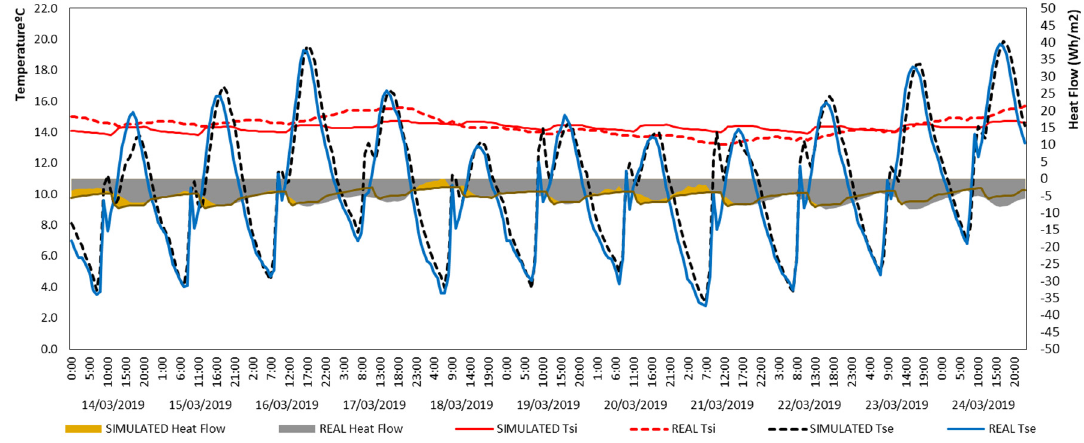
Figure 7. Simulated test results with the contour conditions of the in situ test.